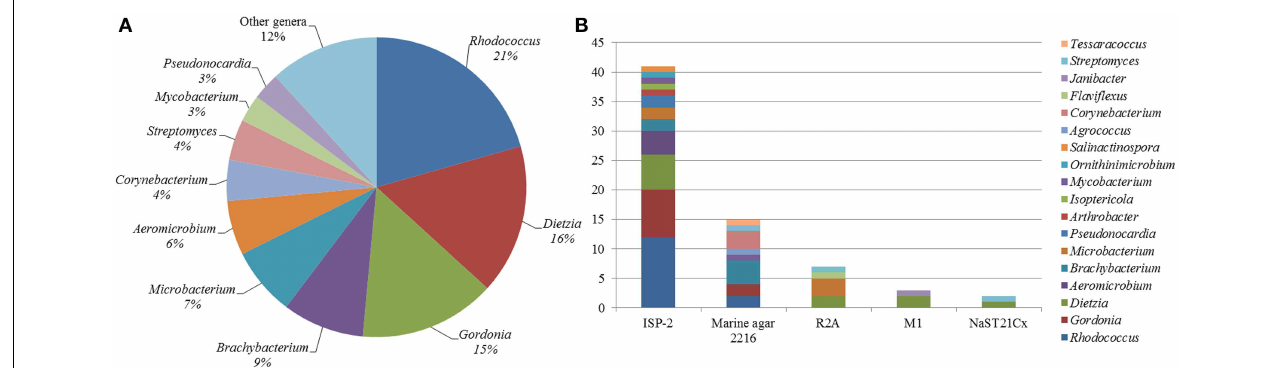
FIGURE 2 | Diversity of culturable Actinobacteria from Valparaíso. (A) Pie chart representation of the percentage frequency of actinobacterial genera within the total number of isolates. (B) Number of actinobacterial isolates according to the culture media used.